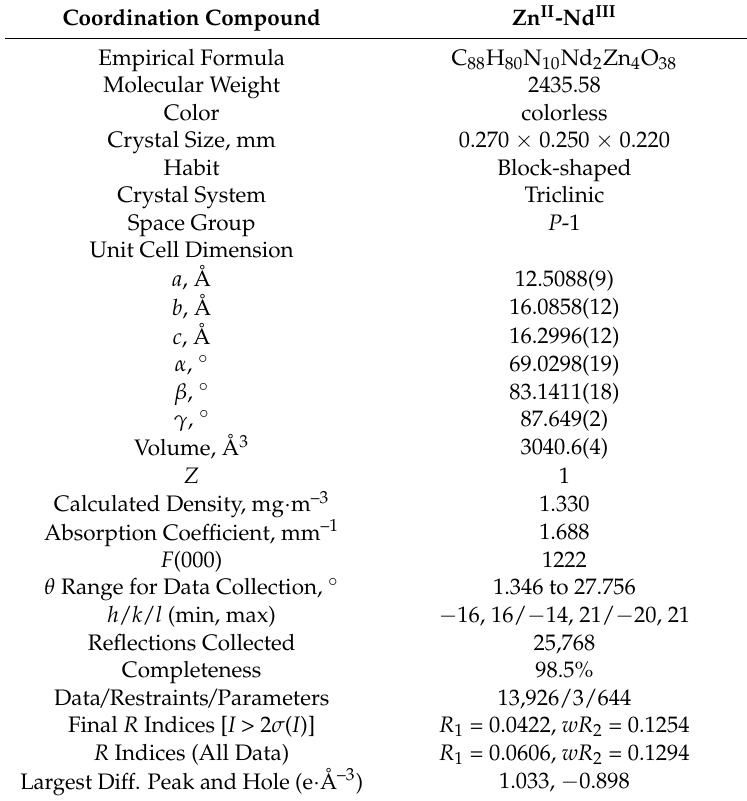
Table 1. Crystal data and structure refinement for the Zn II -Nd III coordination compound.